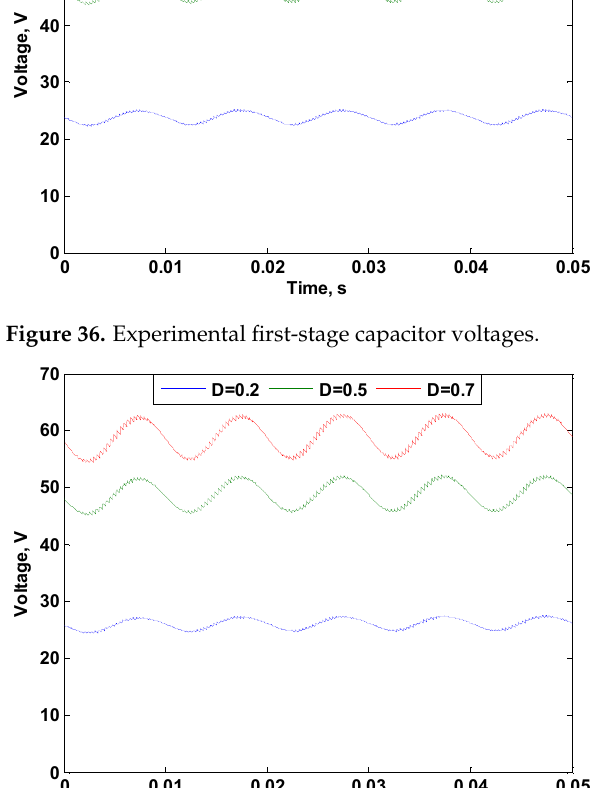
Figure 37. Experimental second-stage capacitor voltages.